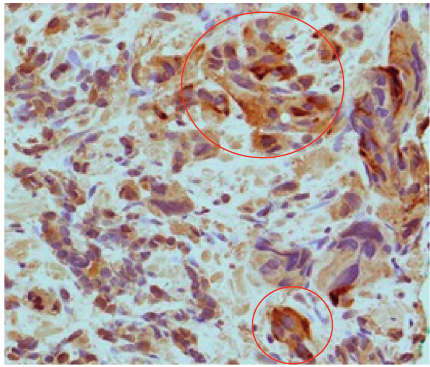
Figure 4: Positive ACTH immunohistochemical staining of prostate tumour (within the circle).